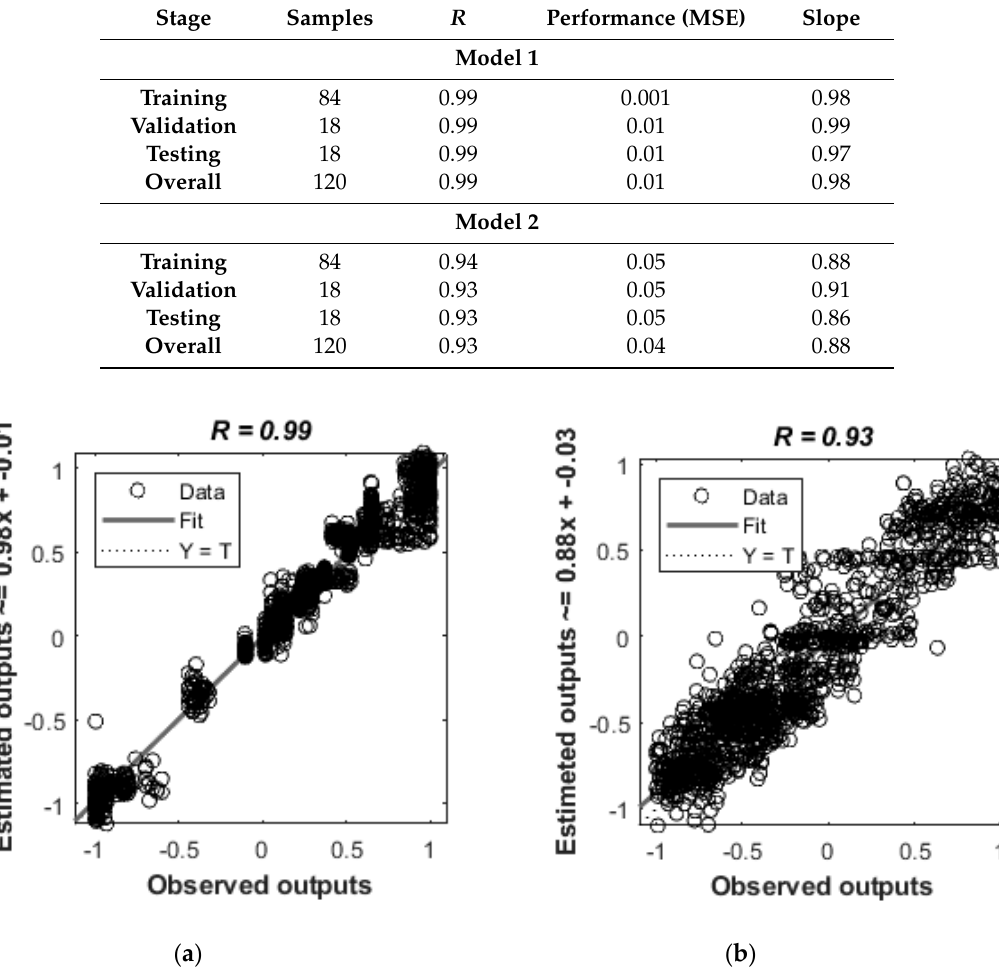
Figure 4. Results of artificial neural networks (ANN); ( a ) Model 1 using physicochemical data as targets and readings of the whole near-infrared wavelength range (1596–2396 nm) as inputs. ( b ) Model 2 using outputs of Model 1 as targets and sensory responses (basic taste intensities) as inputs. The observed values are shown on the x-axis and the estimated values on the y-axis.